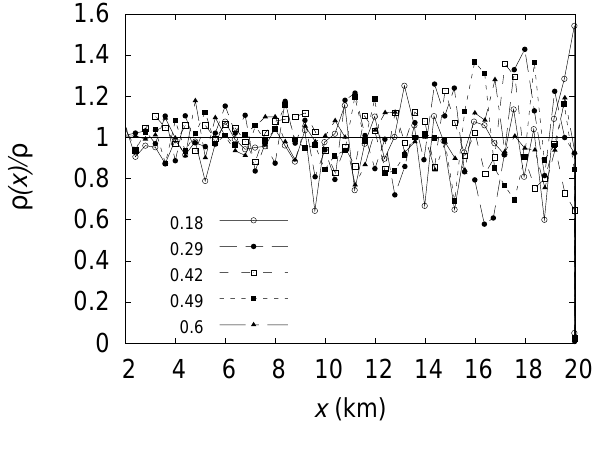
Fig. 12. The local dune density ρ(x) as function of downwind dis- tance remains constant along the whole field independent of the boundary conditions. In the figure ρ(x) is normalized by the to- tal density ρ .